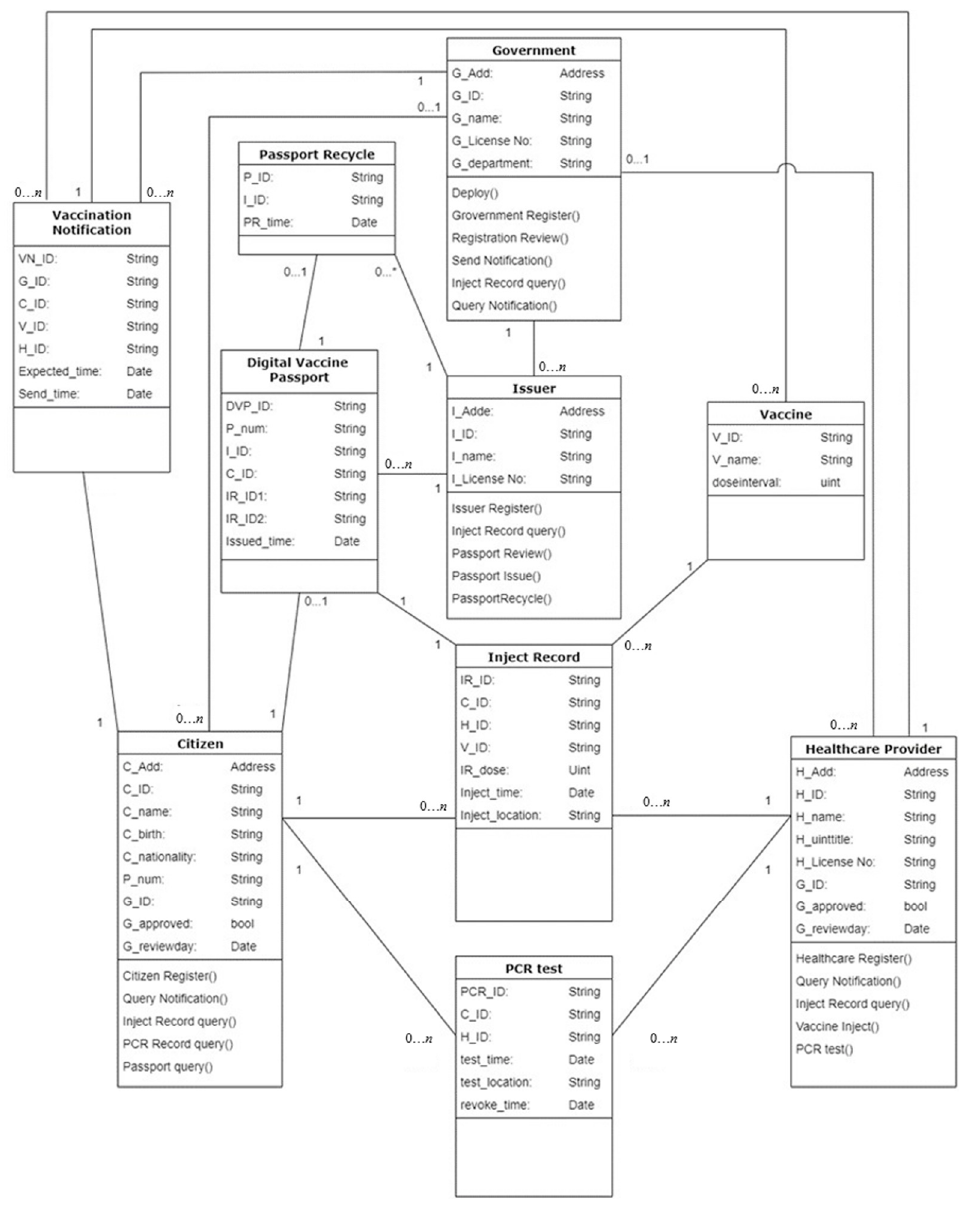
Figure 9. Entity relationship diagram.